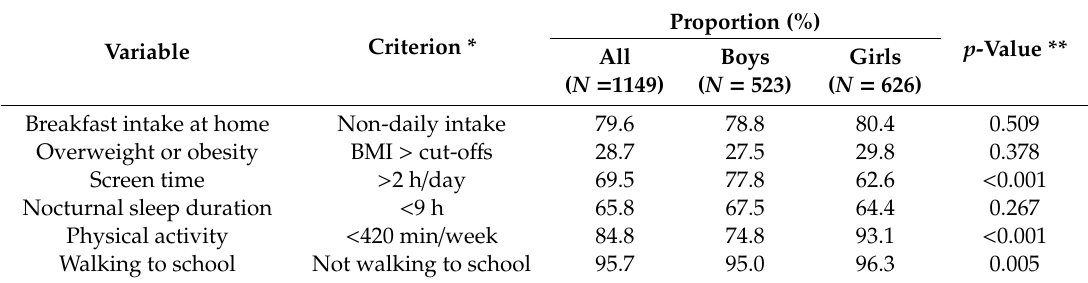
Table 2. The proportions (%) of Saudi children who exceeded certain cut-o ff values for breakfast intake, overweight / obesity, and selected lifestyle behaviors.